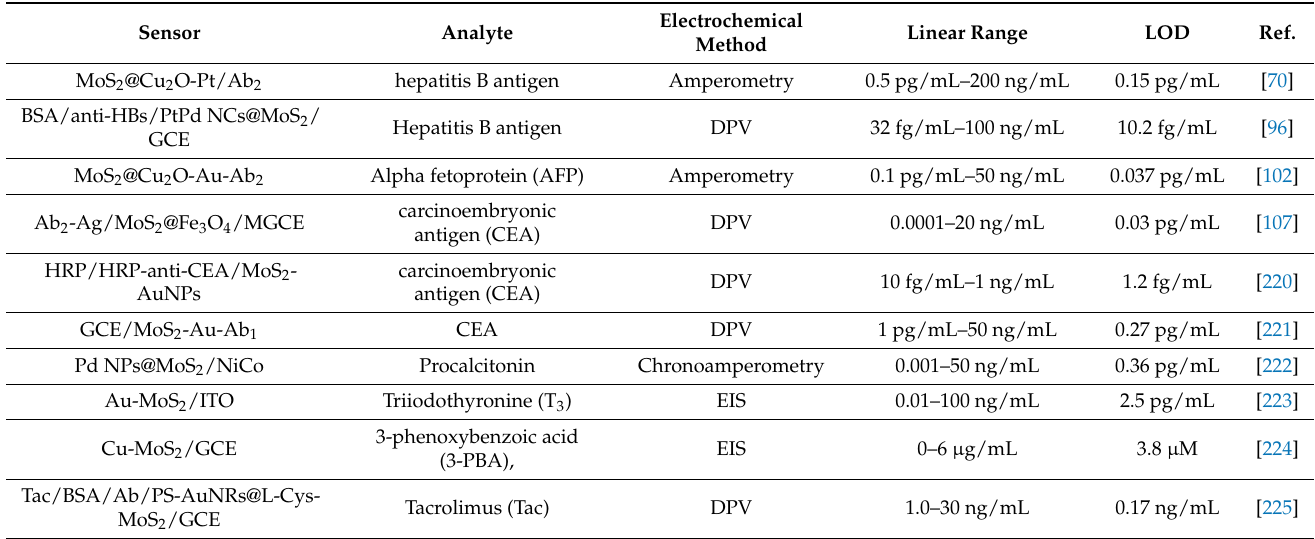
Table 3. Electrochemical immunosensors based on 2D-MoS 2 /metal-NSs composites. Electrochemical Linear Range LOD Sensor Analyte Method